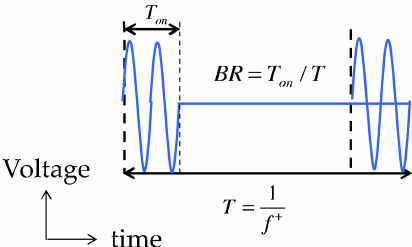
Figure 3. Schematic picture of frequencies for the burst